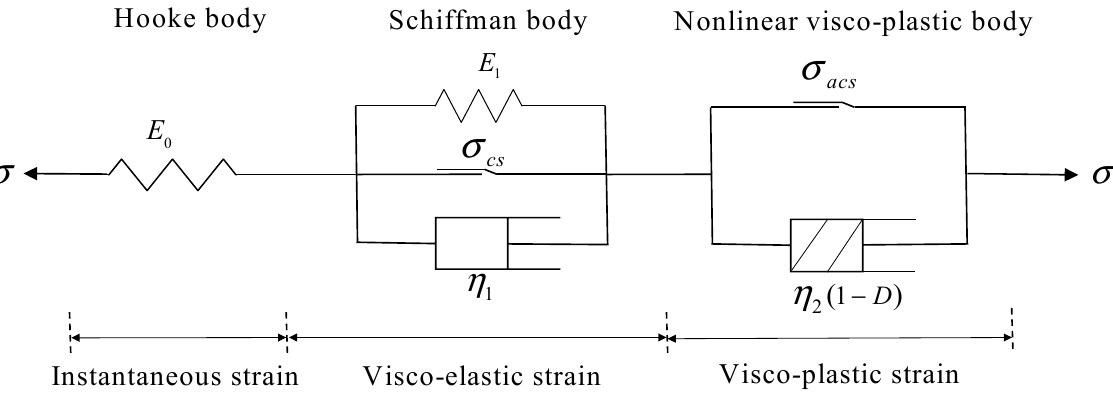
Figure 10. A new multi-element nonlinear creep damage model for dolomitic limestone.